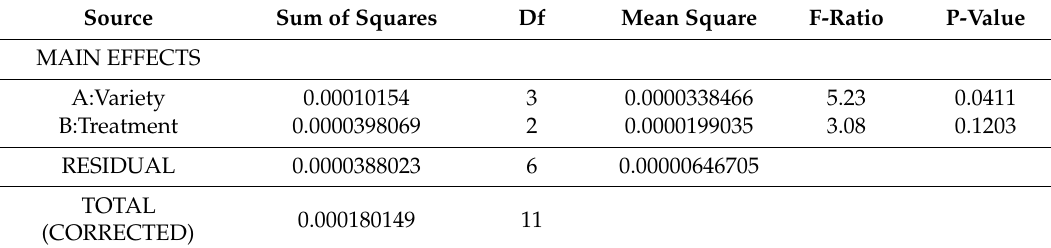
Table 2. Analysis of variance for the Simpson index-Type III Sums of Squares.